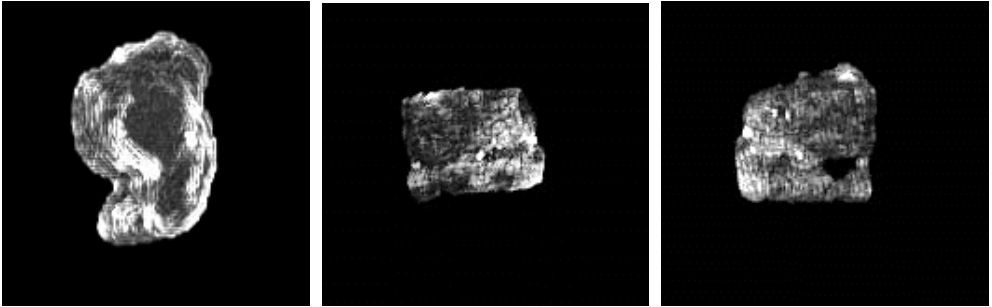
Figure 13. Reconstructive transparent 3D view of liver tumors [Rotate with the z -axis as the center].